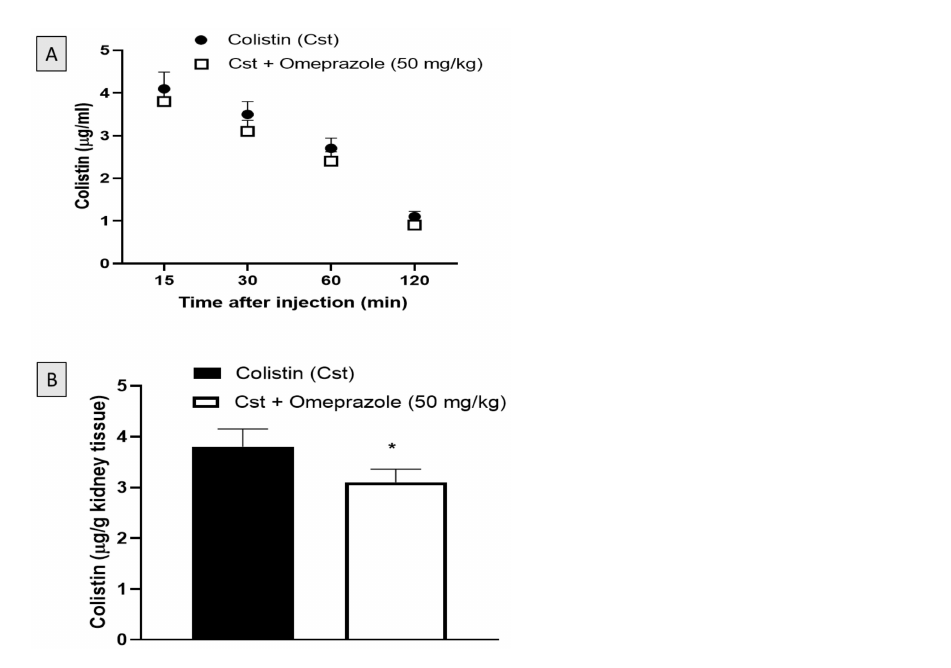
Figure 6. Plasma ( A ) and kidney concentration ( B ) of colistin after an IP injection either alone or with omeprazole (50 mg/kg). Data are shown as M ± SD ( n = 6). * Significantly different from corresponding Cst value as determined by Student’s t test at p <